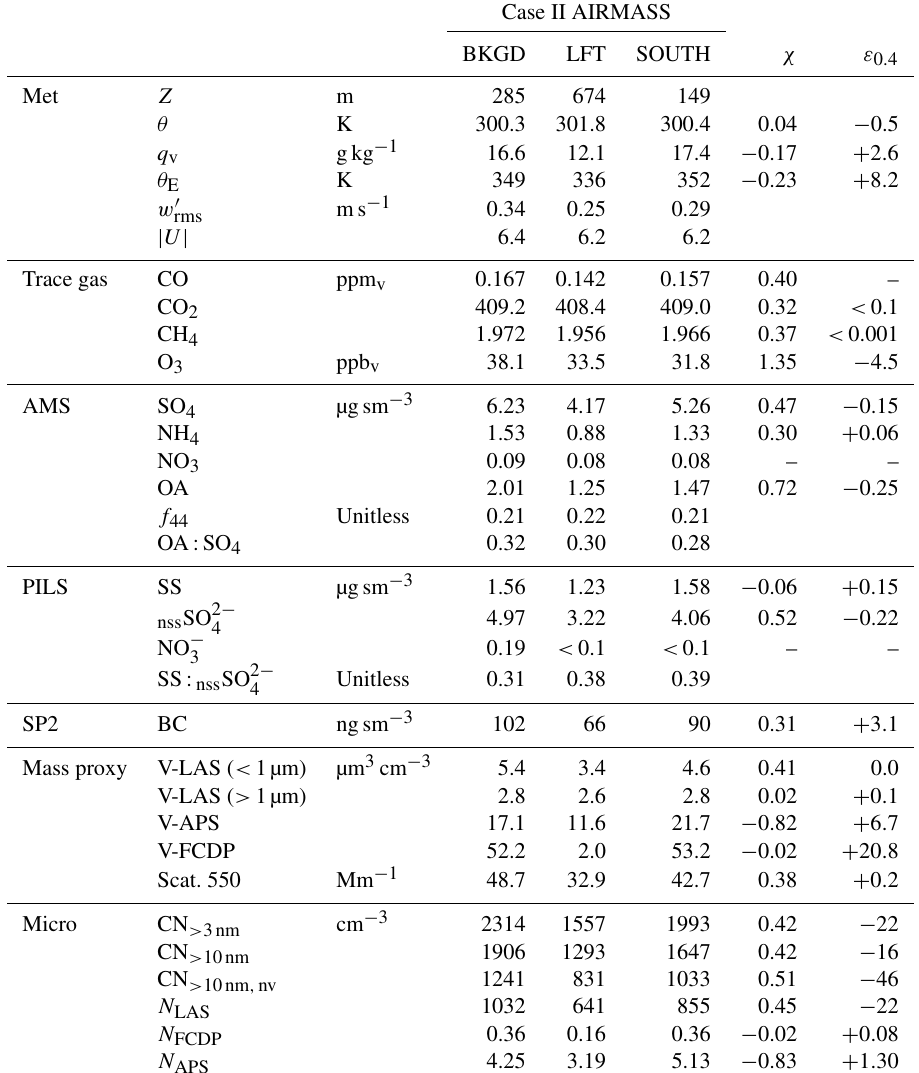
Table 3. Case II air-mass properties pertaining to the sub-cloud background (BKGD), characteristic lower free troposphere (LFT) and a perturbed sub-cloud air mass located on the southern flank of the convection (SOUTH). χ and ε 0 . 4 represent mixing fractions and anomalies of the perturbed air mass, respectively (see